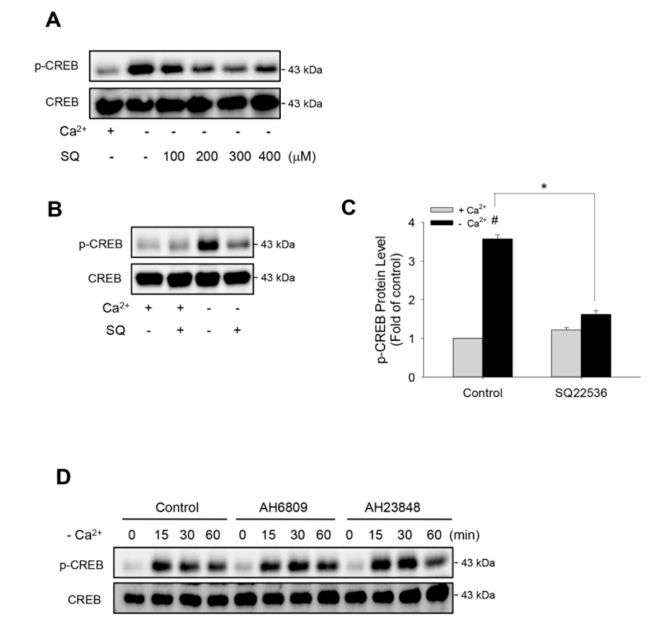
Figure 3. E ff ects of adenylyl cyclase inhibitor and prostaglandin receptor blockers on low Ca 2 + -induced CREB phosphorylation. ( A , B ) Suppression of CREB phosphorylation by adenylyl cyclase inhibitor. As4.1 cells were pretreated with the indicated concentrations of SQ 22536 ( A ) or 300 µ M SQ 22536 ( B ) for 30 min, then exposed to Ca 2 + -free medium for an additional 15 min. Cellular proteins were extracted and subjected to Western blot analysis for phosphorylated and total level of CREB. ( C ) Densitometric quantitation of the phosphorylated level of CREB in B. The data are expressed as relative intensity of the band against the control (mean ± SE, n = 4). # p < 0.01 versus normal Ca 2 + control; * p < 0.01 versus SQ 22536-treated cells. ( D ) E ff ect of EP2 and EP4 blockers on CREB phosphorylation. As4.1 cells were pretreated with or without 20 µ M EP2 inhibitor AH6809 or EP4 inhibitor AH23848 for 30 min, then exposed to Ca 2 + -free medium for the indicated time intervals. Cellular proteins were extracted and subjected to Western blot analysis for phosphorylated and total level of